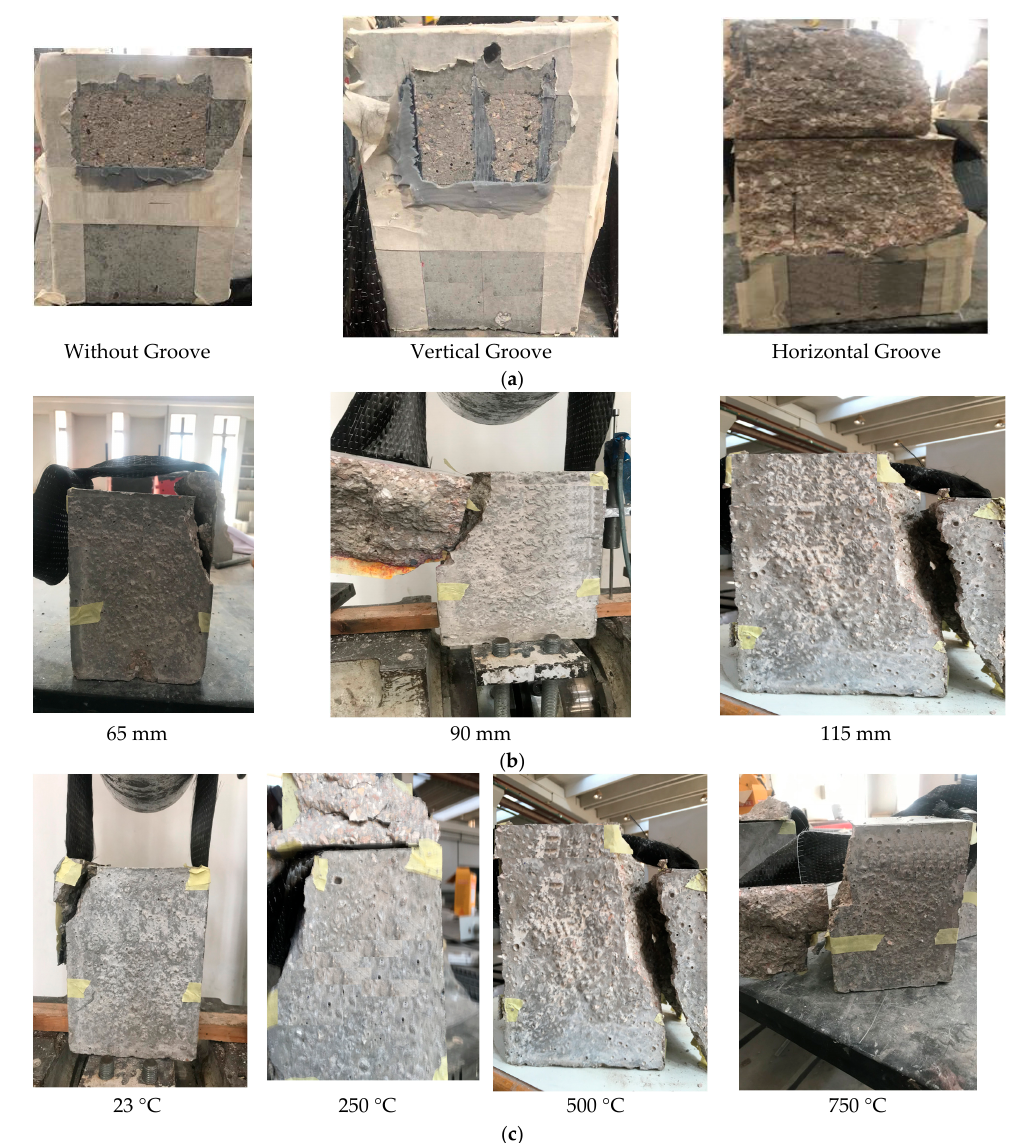
Figure 5. Typical mode of failure. ( a ) Specimens with different drilling diameters; ( b ) specimens with different CFRP bonded lengths; ( c ) specimens with different temperature degrees.